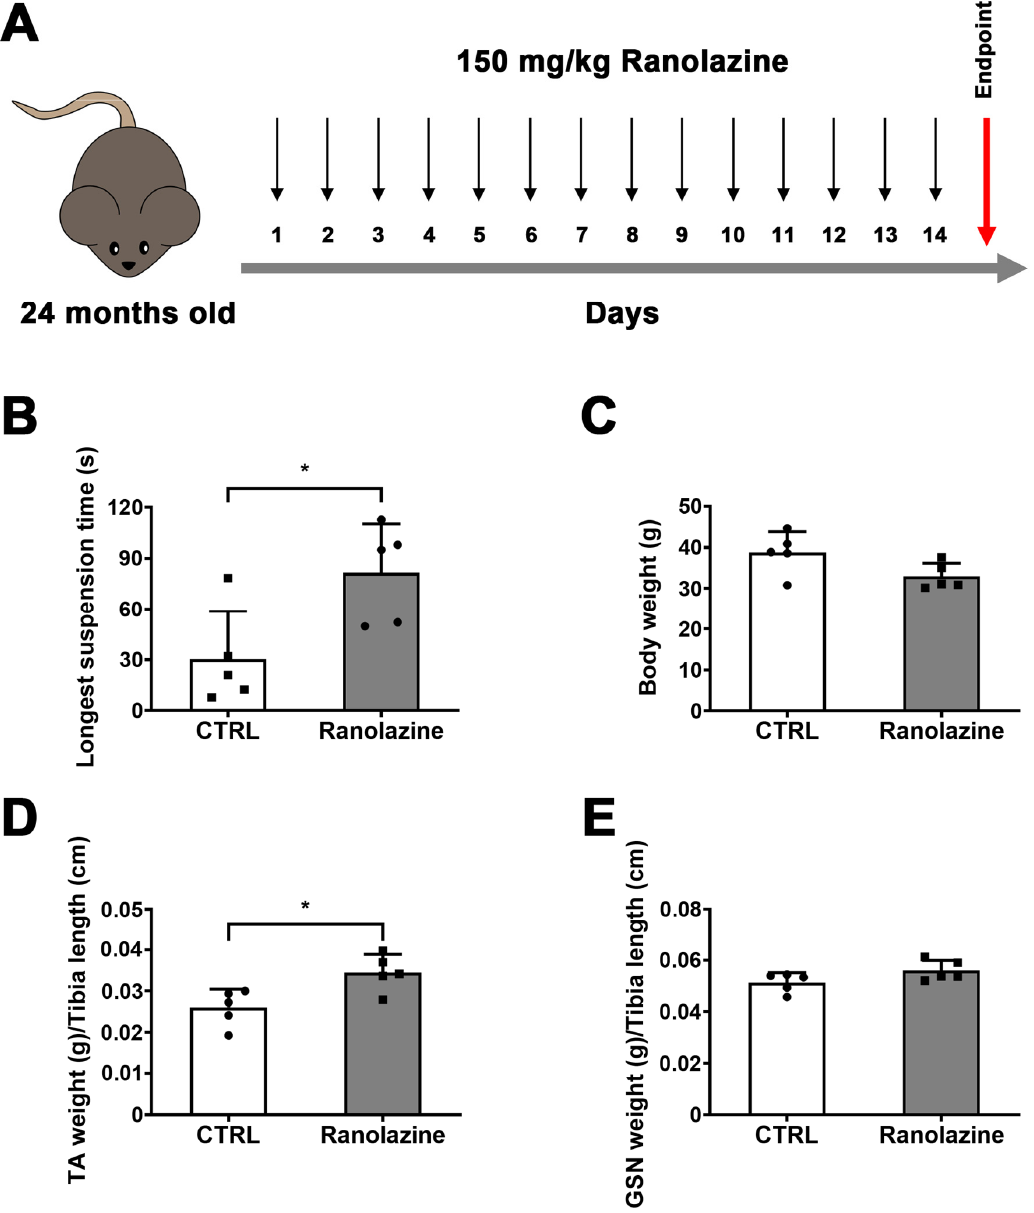
Figure 1. Fourteen-day-long treatment with Ranolazine increases the strength of old sarcopenic mice. ( A ) Experimental scheme for a 14-day-long Ranolazine treatment (by oral gavage) of 24-month-old C57BL/6 mice. Untreated mice were administered water. ( B ) Longest suspension time measured by inverted screen test (or mesh test) of untreated control (CTRL) mice and Ranolazine-treated mice. ( C ) Total body weight of mice included in the experiment and recorded before the sacrifice. ( D , E ) Weight of tibialis anterior (TA; ( D )) and of gastrocnemius muscles (GSN; ( E )) of untreated control (CTRL) mice and Ranolazine-treated mice normalized per tibia length. Values are means ± SD. n = 5 for both experimental conditions. Unpaired t -test was used for comparison. * = p <